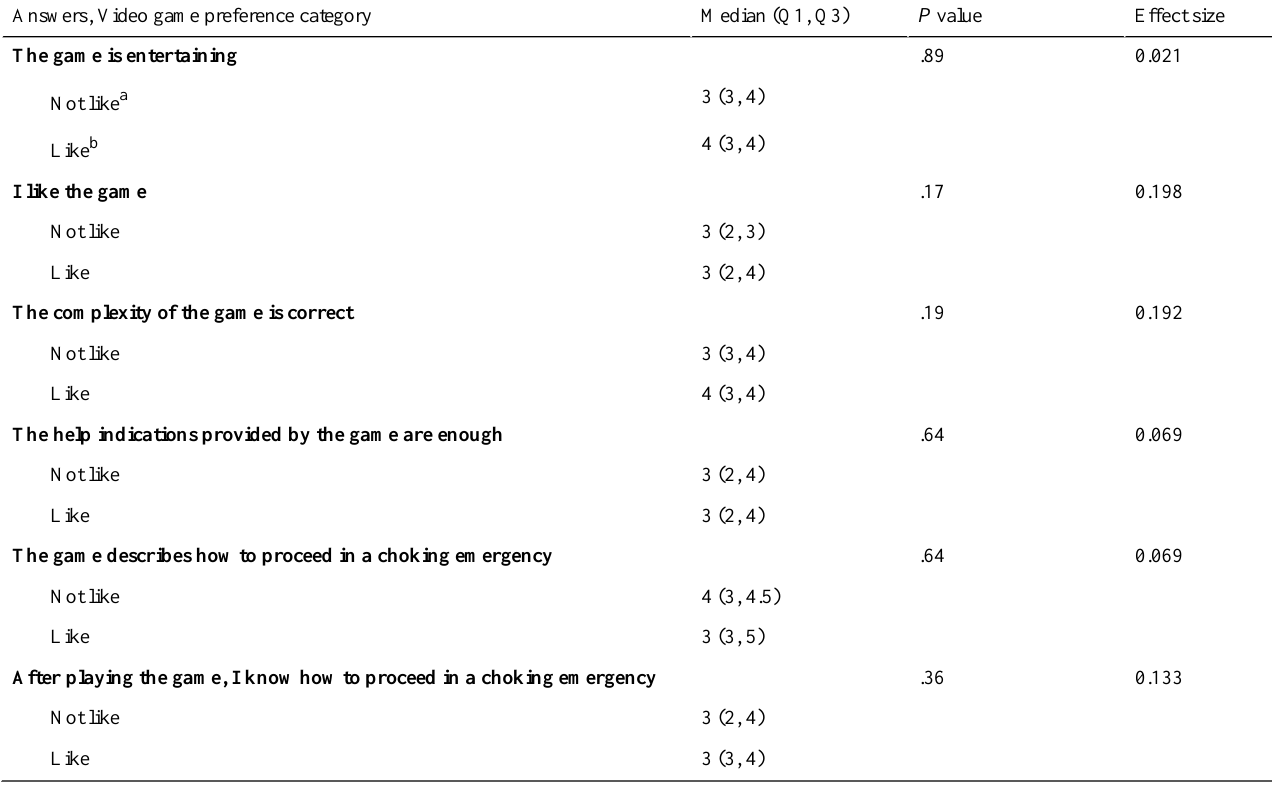
Table 3. Descriptive statistics of the answers to the questions related to the game (grades 1-5) depending on whether the students like video games or